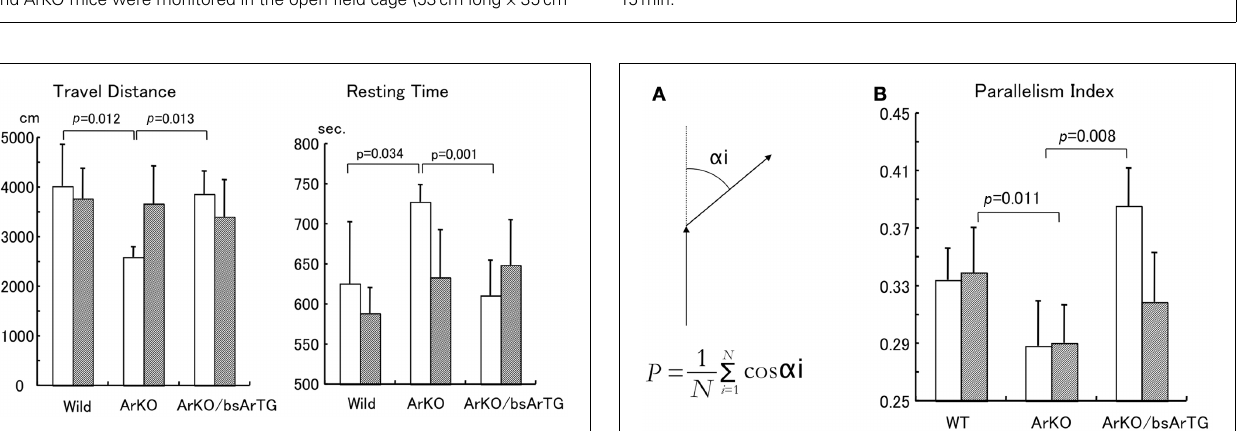
wide × 30cm high) by a video-recorder with infrared night scope.Time-series data of wild-type (A) and ArKO (B) mice were collected at 200ms intervals for 15min.